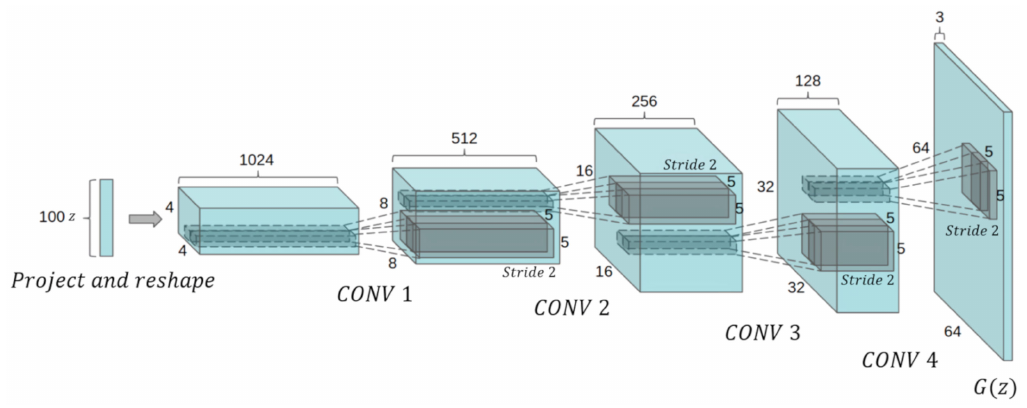
Figure 5. Generator structure of DCGAN (Deep Convolutional Generative Adversarial Networks)